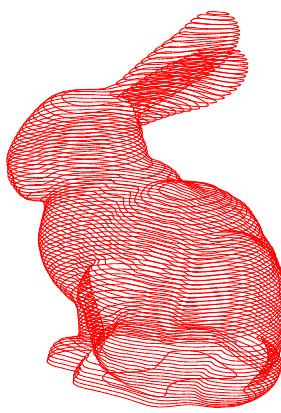
Figure 5. GPU parallel slicing for fast data processing.